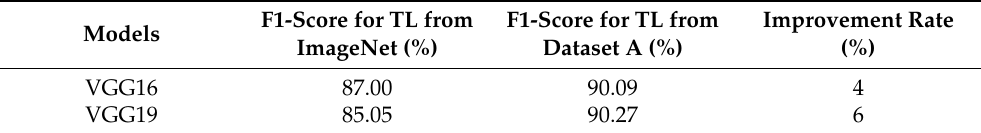
Table 12. Improvement rate after transfer learning from labeled data (Dataset